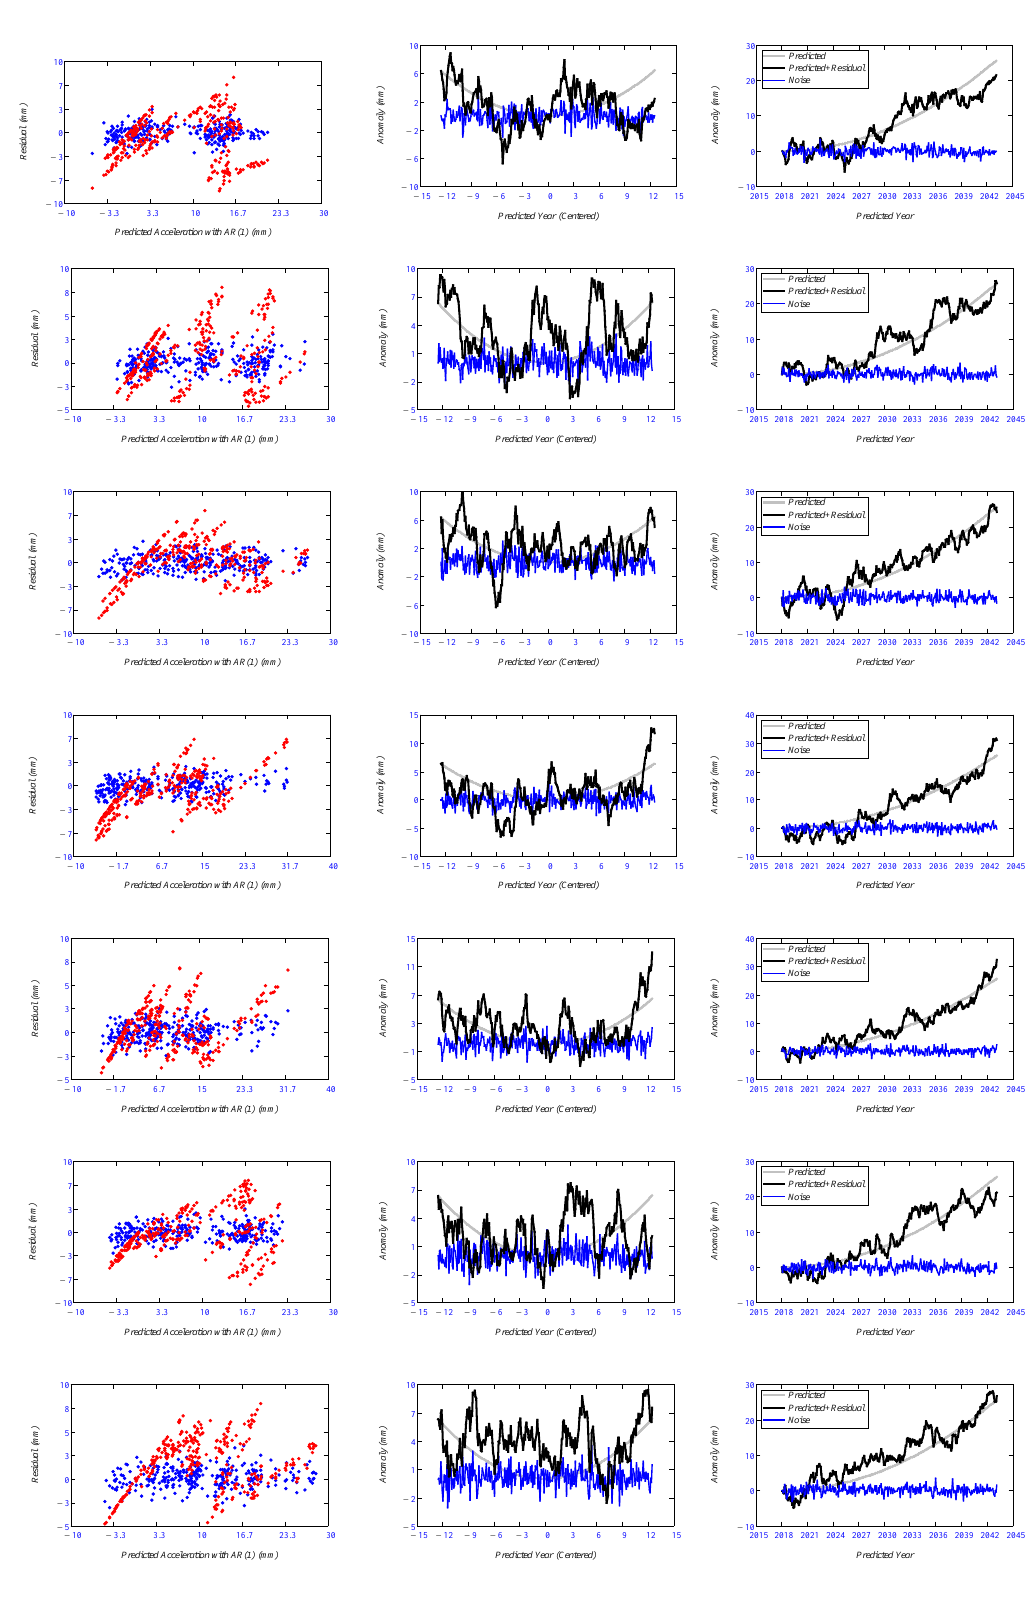
Fig. 8. Future manifestations of the GMSL anomalies due to a contingent acceleration. Contribution due to the trend is not